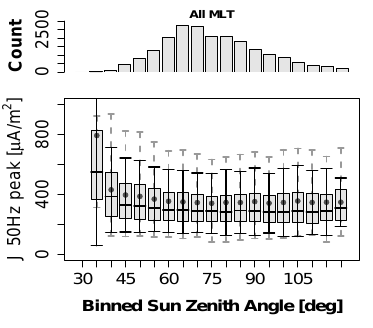
Fig. 14. Width of bursts as a function of K p . Same format as in Fig.